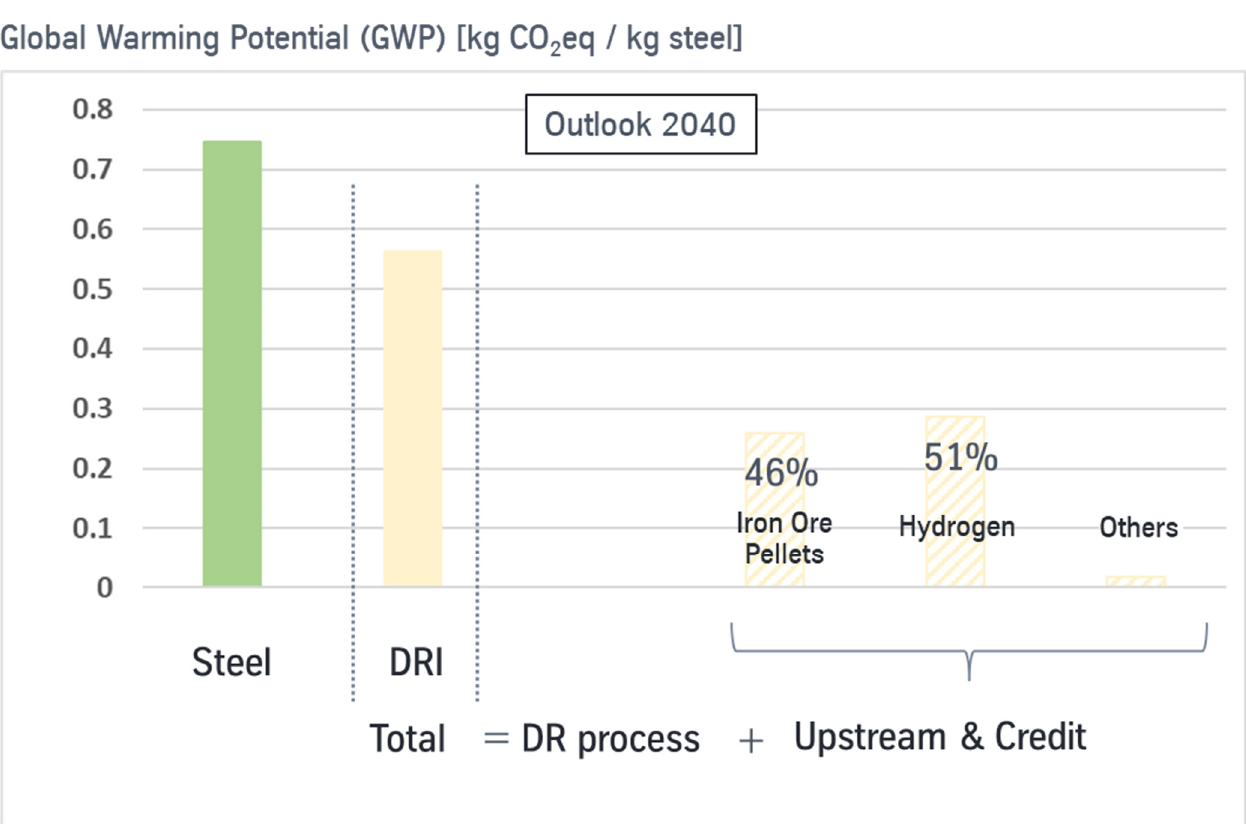
Figure 11. Carbon footprint of steel and impact of the H 2 -based DRI production for the year 2040. Hydrogen is produced via electrolysis driven by the European grid mix following the sustainable development scenario in Figure 4 [34].